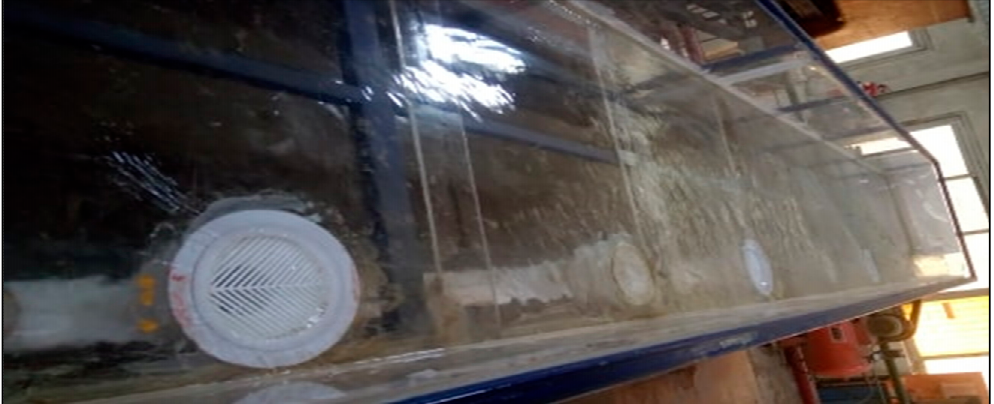
Figure 5. The flume of experimental tests.